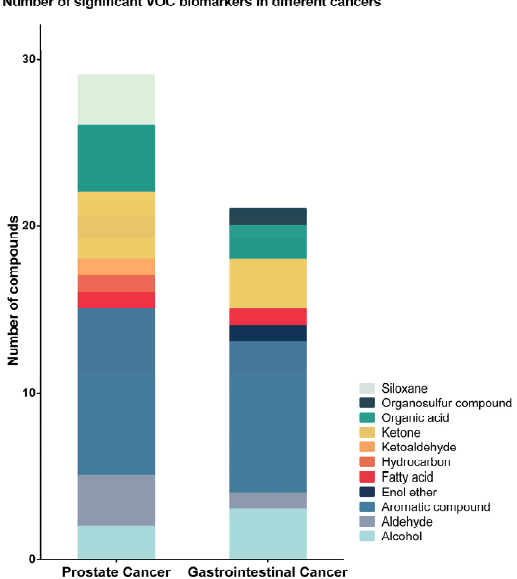
Figure 2. Number of identified volatile organic compounds (VOCs) in different cancers. For prostate cancer, 29 urinary VOCs from nine chemical classes were identified, and the majority of them were aromatic compounds, ketones, and organic acids. For gastrointestinal cancer, 21 VOCs from eight chemical classes were identified, 19 of which were not identified in prostate cancer urine. The majority were aromatic compounds, alcohols, and ketones.